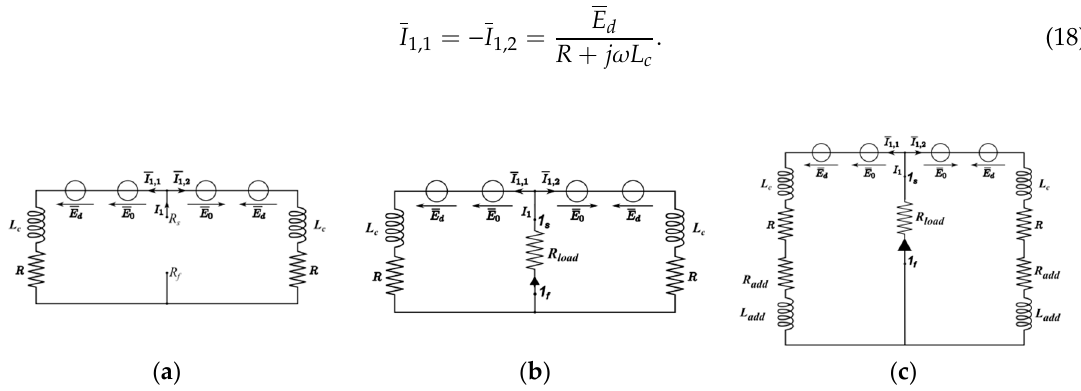
Figure 16. Electrical circuit for the experimental measurements with ( a ) the motor connections in open circuit, ( b ) a resistive charge at motor connections, and ( c ) with additional inductors and a resistive charge at the motor connections .